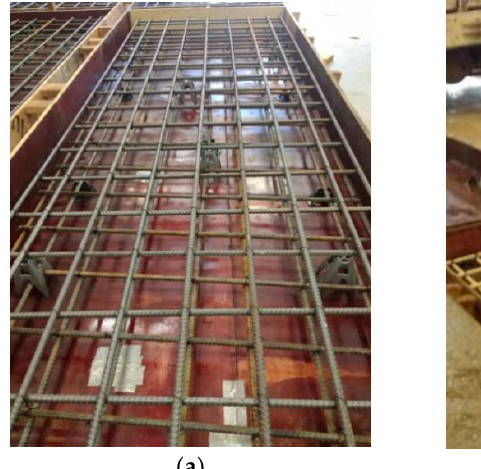
Figure 2. Deck reinforcement layout for ( a ) Steel-Reinforced Decks, ( b ) GFRP-Reinforced Decks, and ( c ) Hybrid Decks.